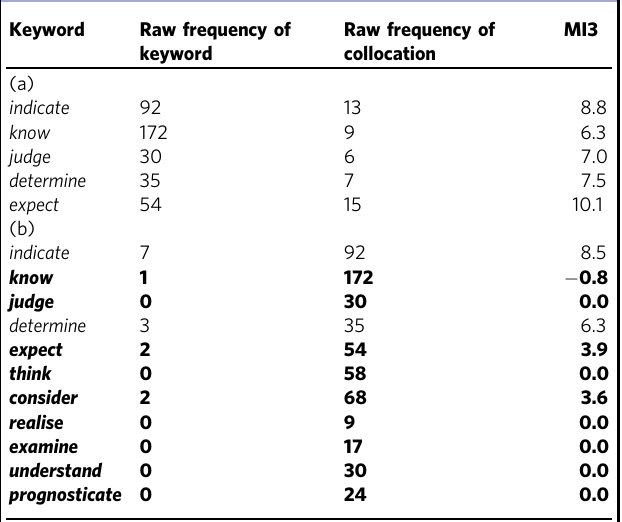
Table 13 (a) Keyword collocates with SYMPTOM, raw frequency = 348. (b) Keyword collocates with SIGN, raw frequency =